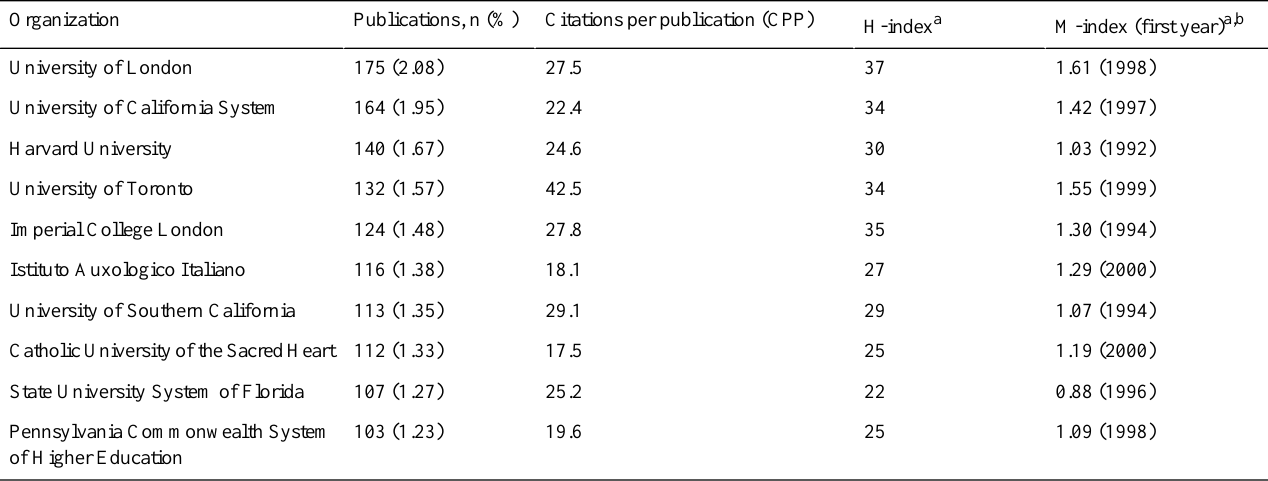
Table 2. The 10 most productive organizations of virtual reality research in medicine (8399 articles).